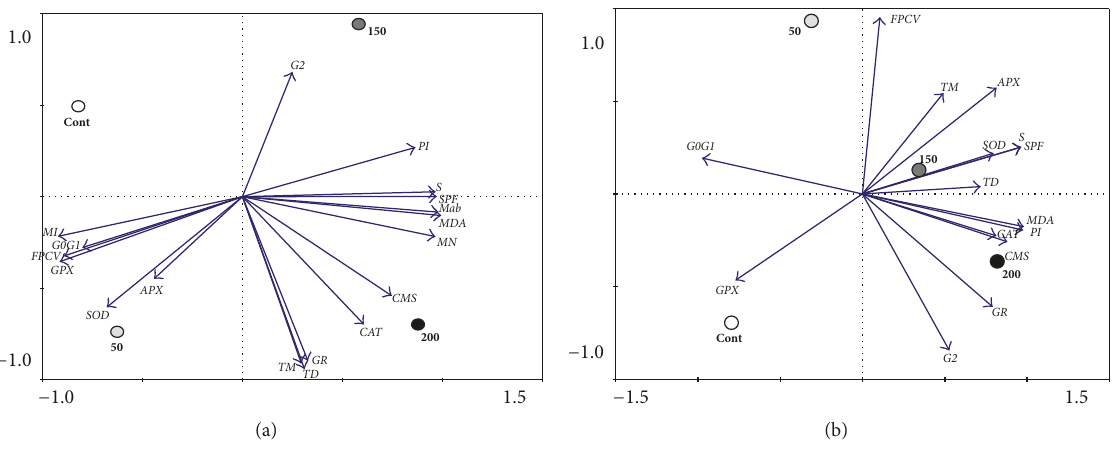
Figure 3: PCA analyses of the oxidative stress and genotoxic effects of Cr(VI) in plants: (a) roots and (b) leaves.